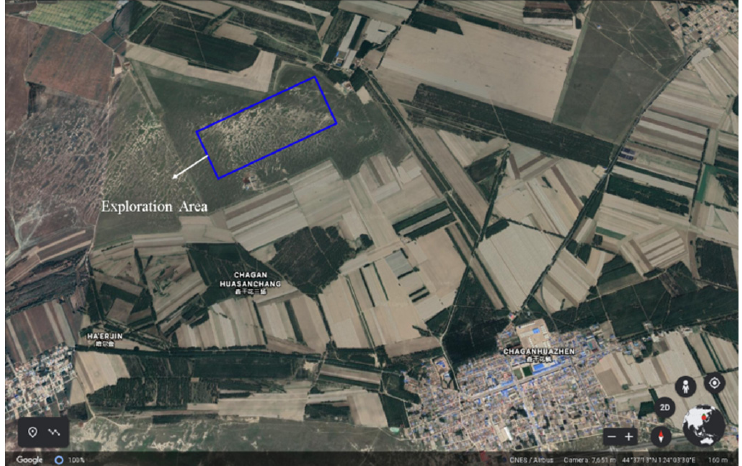
Figure 6. The overview of the field exploration area.